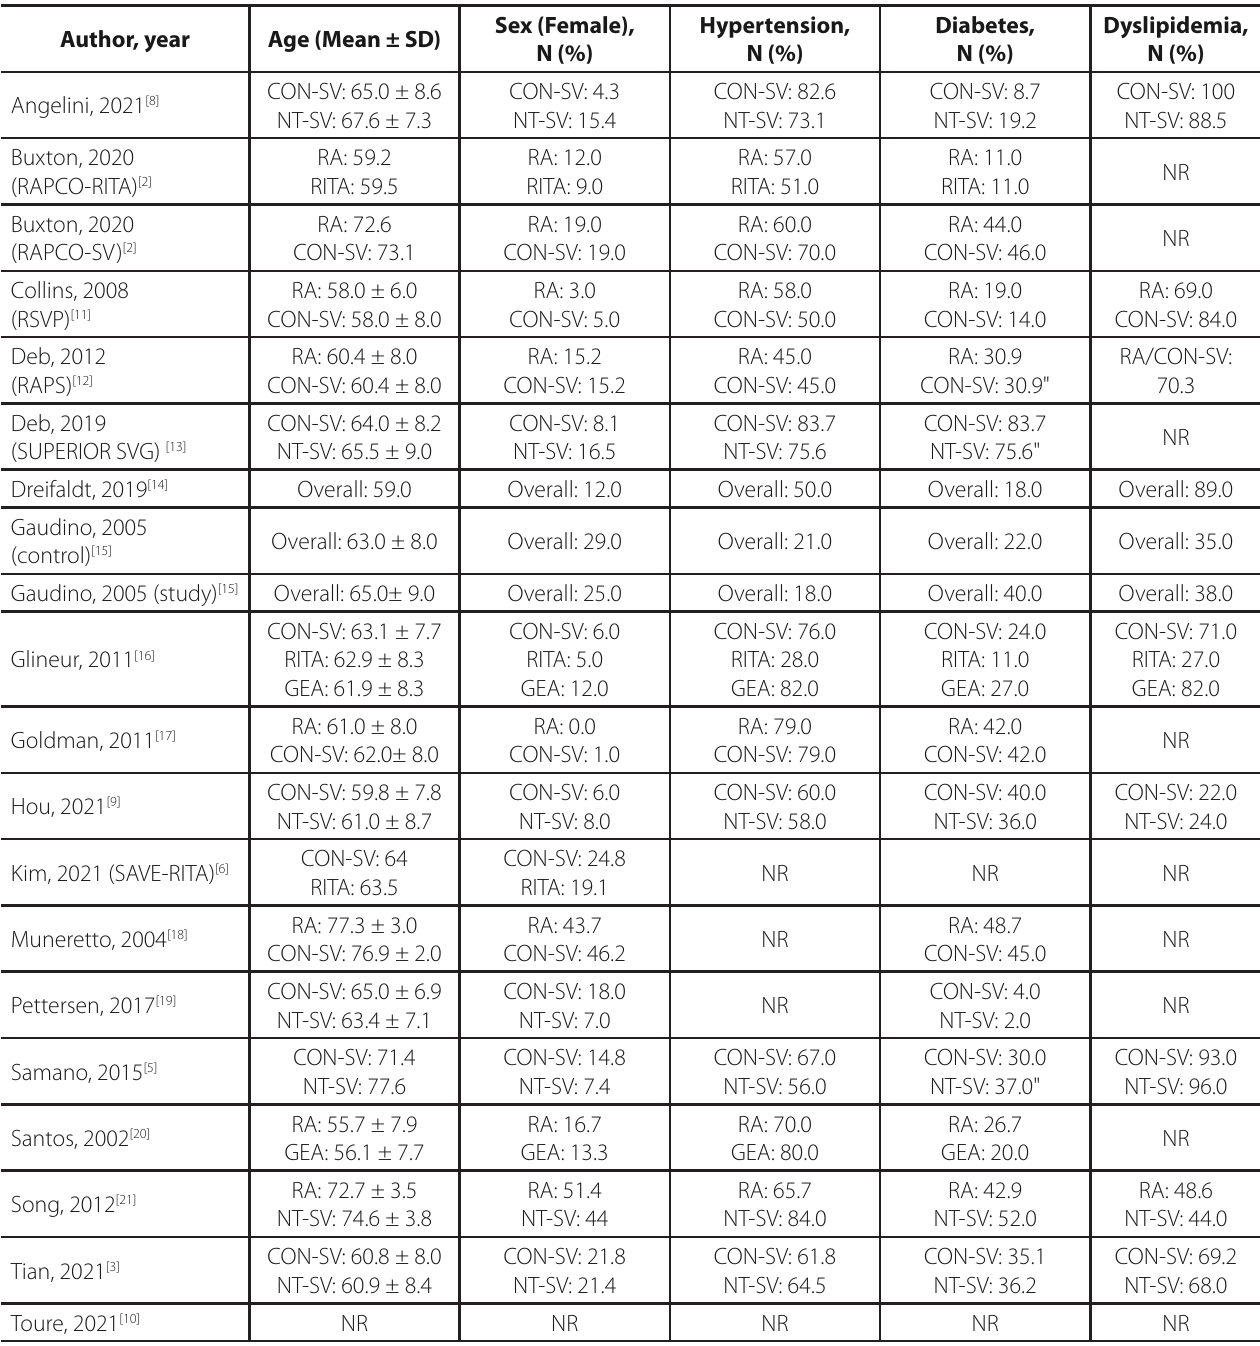
Table S3. Demographics of included patients.